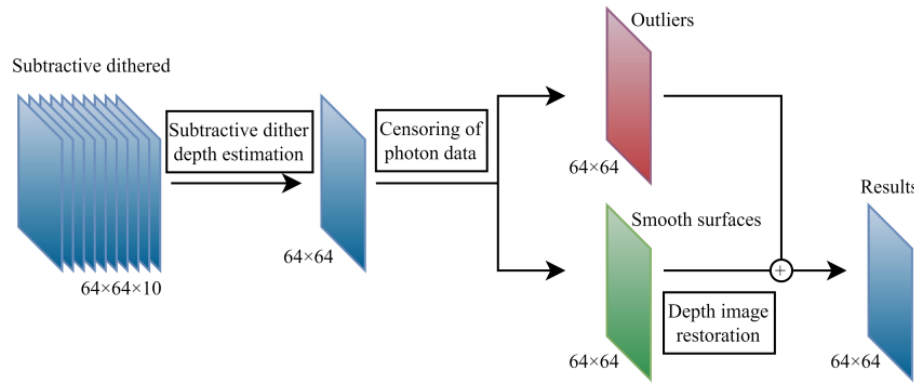
Figure 1. Flowchart of RSPE for depth reconstruction.